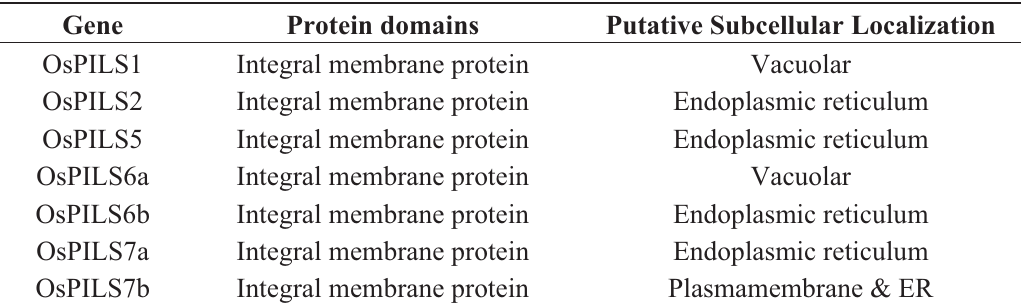
Table 3. Sub-cellular localization of OsPILS proteins. Prediction shows that all OsPILS are integral transmembrane proteins and localized to sub-cellular compartment like endoplasmic reticulum and vacuoles. The OsPILS7b was observed to be localized to endoplasmic reticulum as well as plasmamembrane. Prediction of sub-cellular localization was carried out using online available WOLF PSORT protein sub-cellular localization prediction software